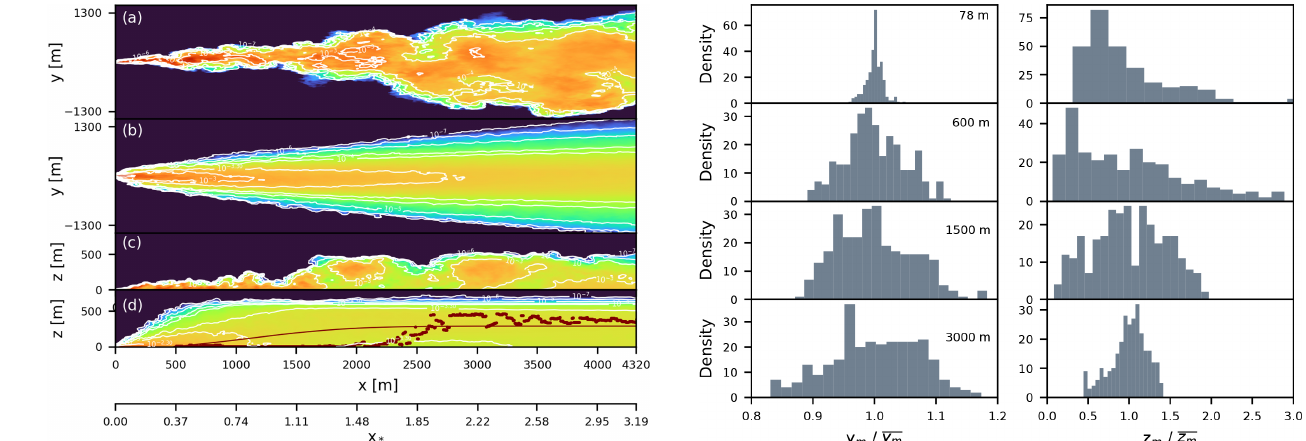
Figure 10. Probability density functions of the instantaneous plume position scaled with the mean centerline position at various down- wind distances from the